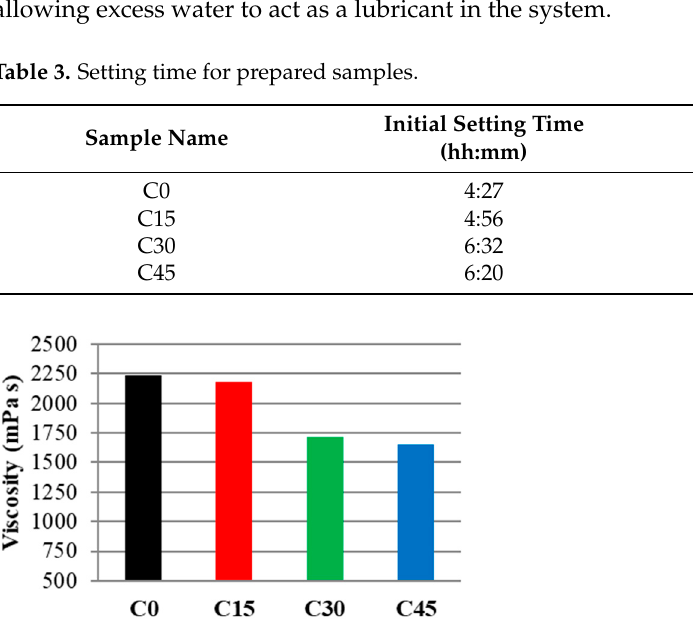
Figure 7. Sample viscosity after 5 min.